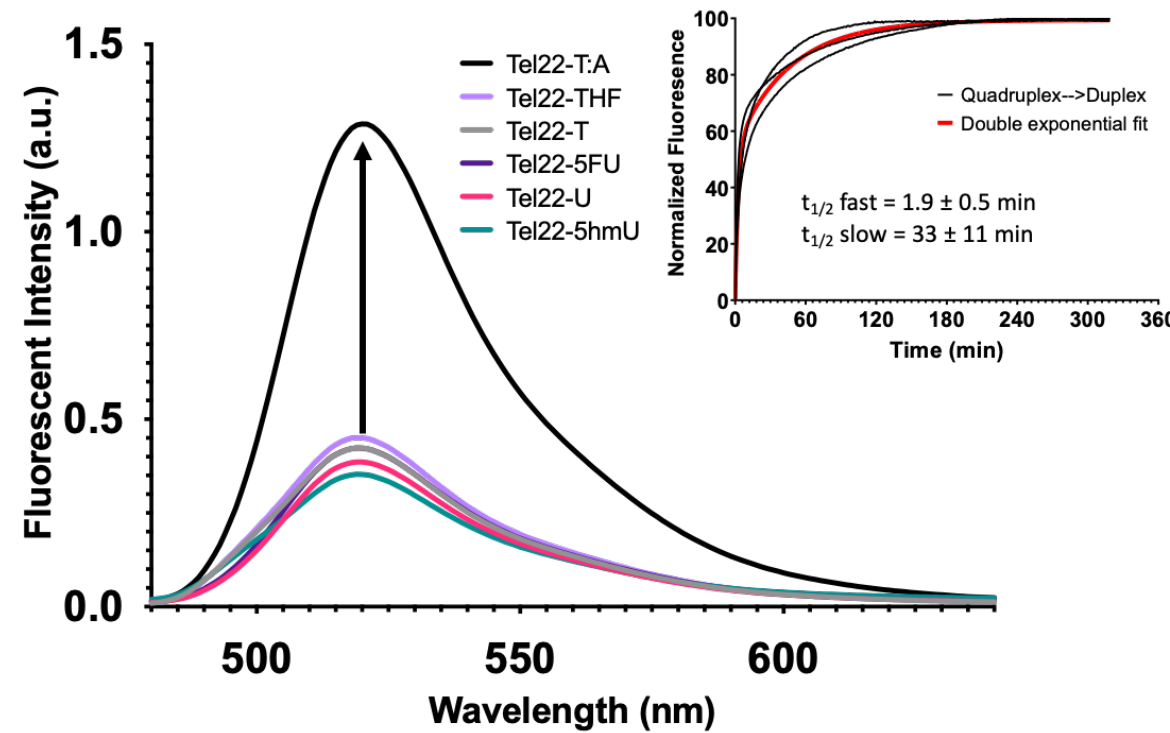
Figure 4. G-quadruplex formation quenched fluorescence and the addition of a complementary strand promoted duplex formation. While quadruplexes are highly stable secondary DNA structures, in the presence of the complementary strand, they are in equilibrium with the corresponding duplex. A FRET strategy was employed to monitor quadruplex formation at 37 °C. Relatively low fluorescent excitation was observed when oligonucleotides formed a G-quadruplex as the